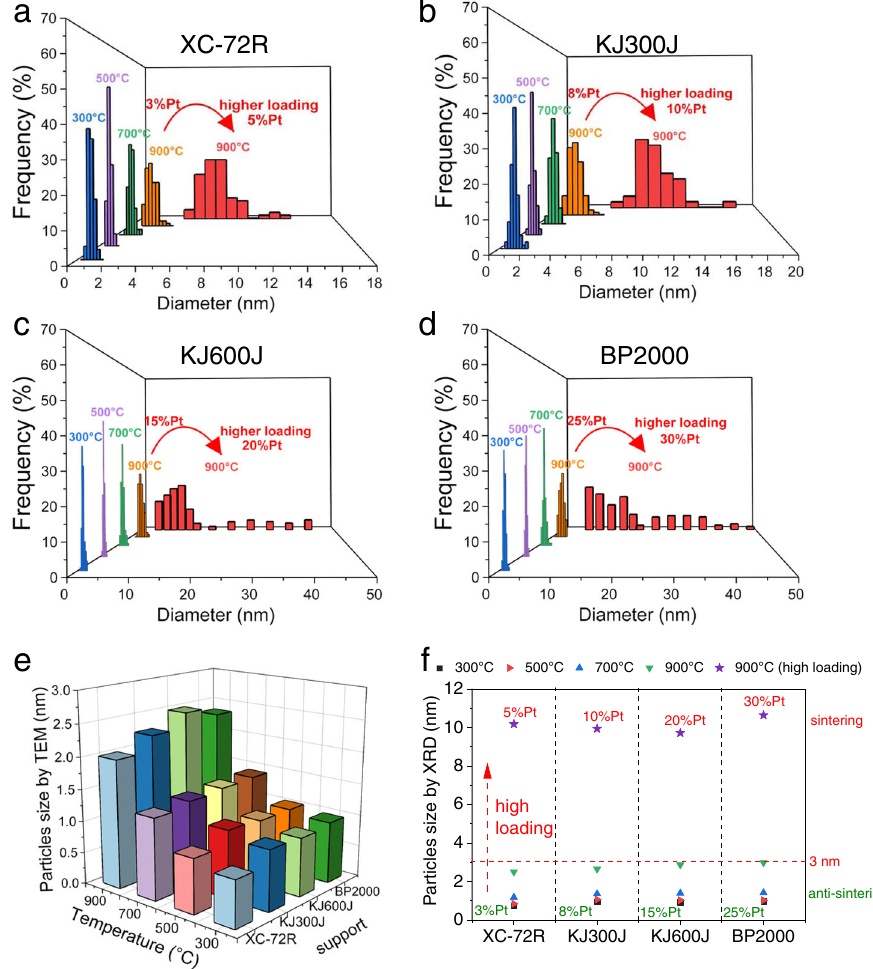
Fig. 2 Particle size evolution of Pt/C catalysts during sintering tests. a – d Particle size distribution of the Pt/C catalysts after sintering tests at different temperatures in 5% H 2 /Ar for 120 min, clearly showing the strong loading-dependent sintering behavior for each carbon support. e Average particle size of the Pt/C catalysts with corresponding critical loading for each support, indicating the sintering resistance of the catalysts. The particle size was estimated from electron microscopy results. f Average particle size of the Pt/C catalysts estimated from XRD results, con fi rming the loading-dependent sintering behavior.